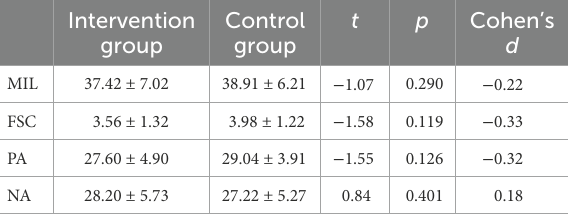
TABLE 1 Baseline scores between intervention and control groups ( M ± SD). Intervention